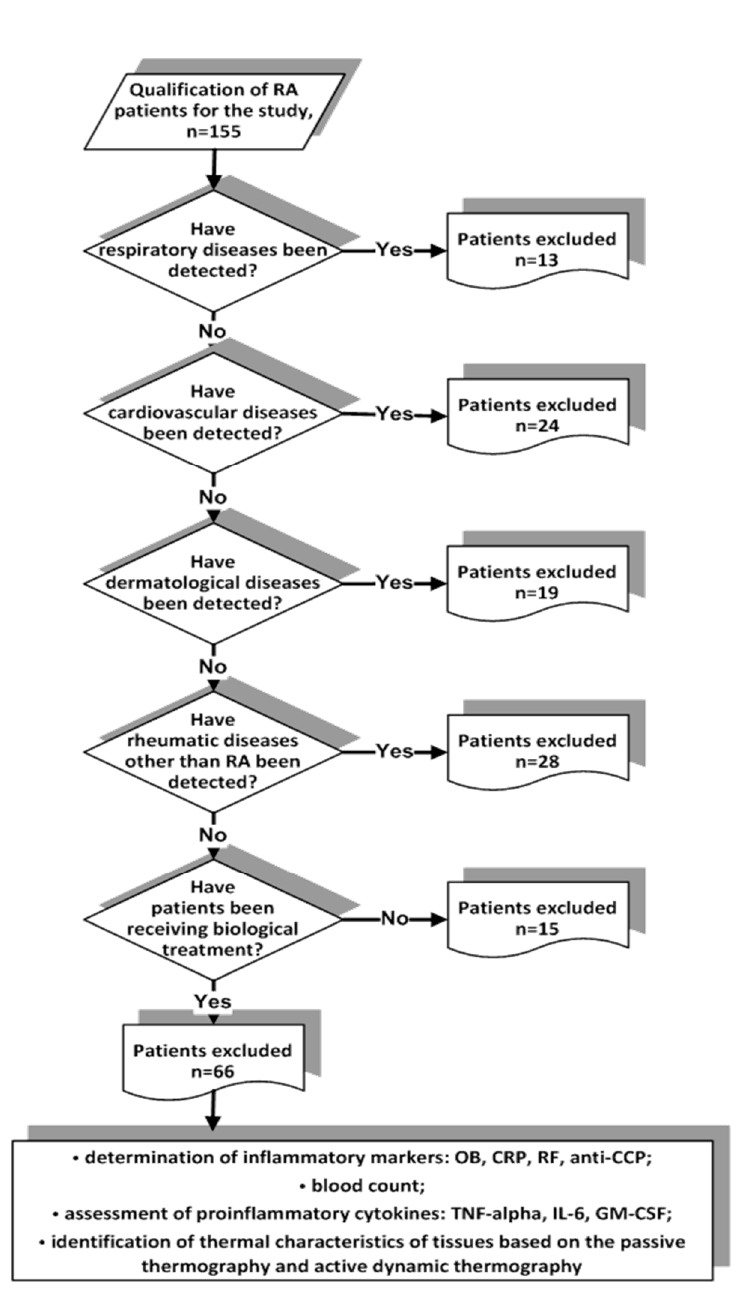
Figure 1. Flowchart for patients classification and data collecting.